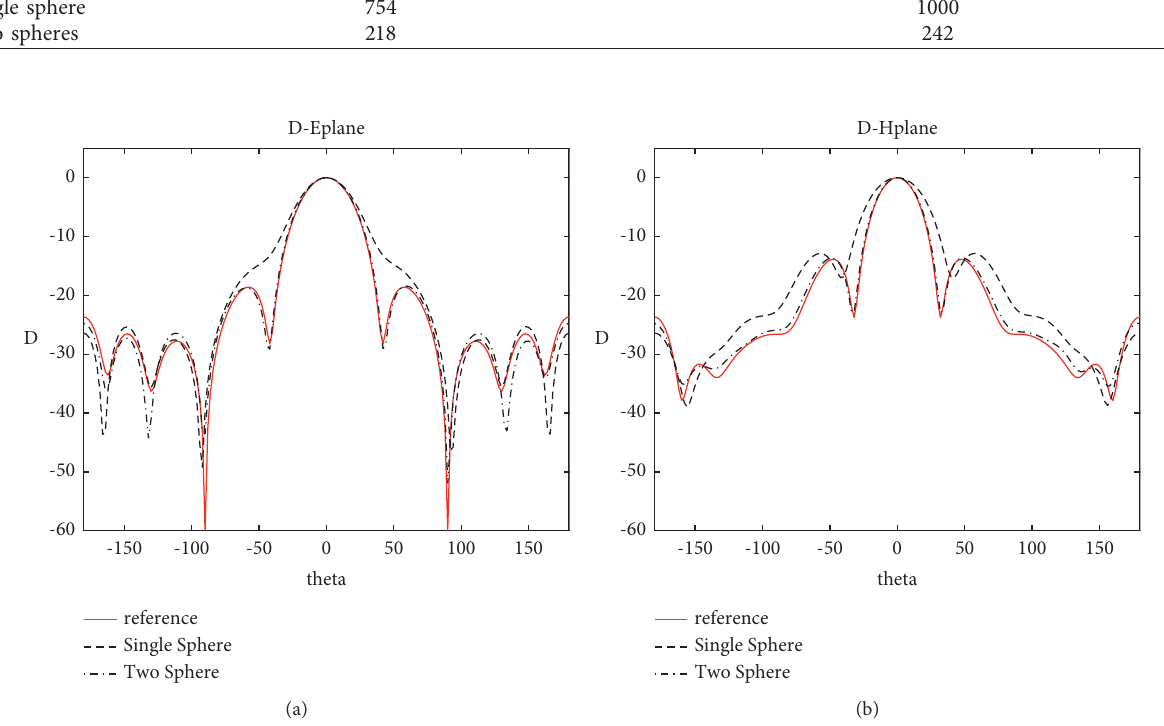
Figure 5: The radiation pattern corresponds to the single and double spherical sampling methods. The left and right figures represent the E- plane and H-plane, respectively. (a) E-plane. (b)